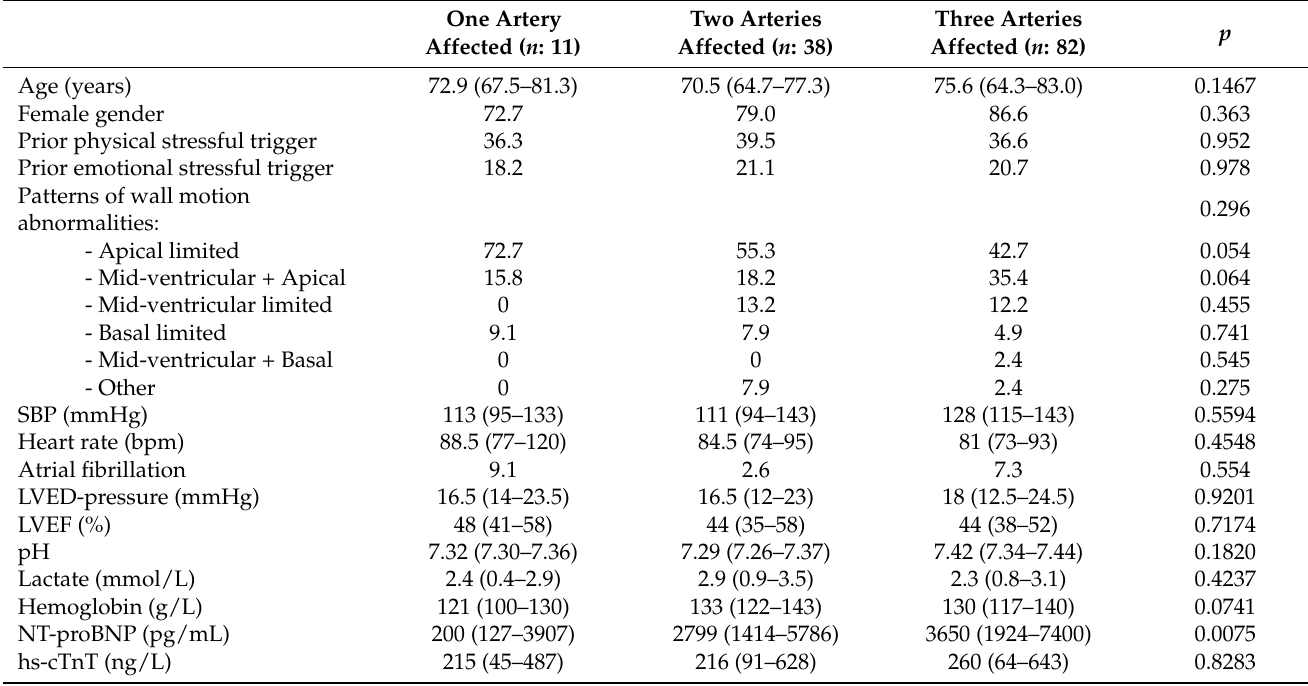
Table 3. Differences in patients based on the number of arteries with CMD ( n : 131